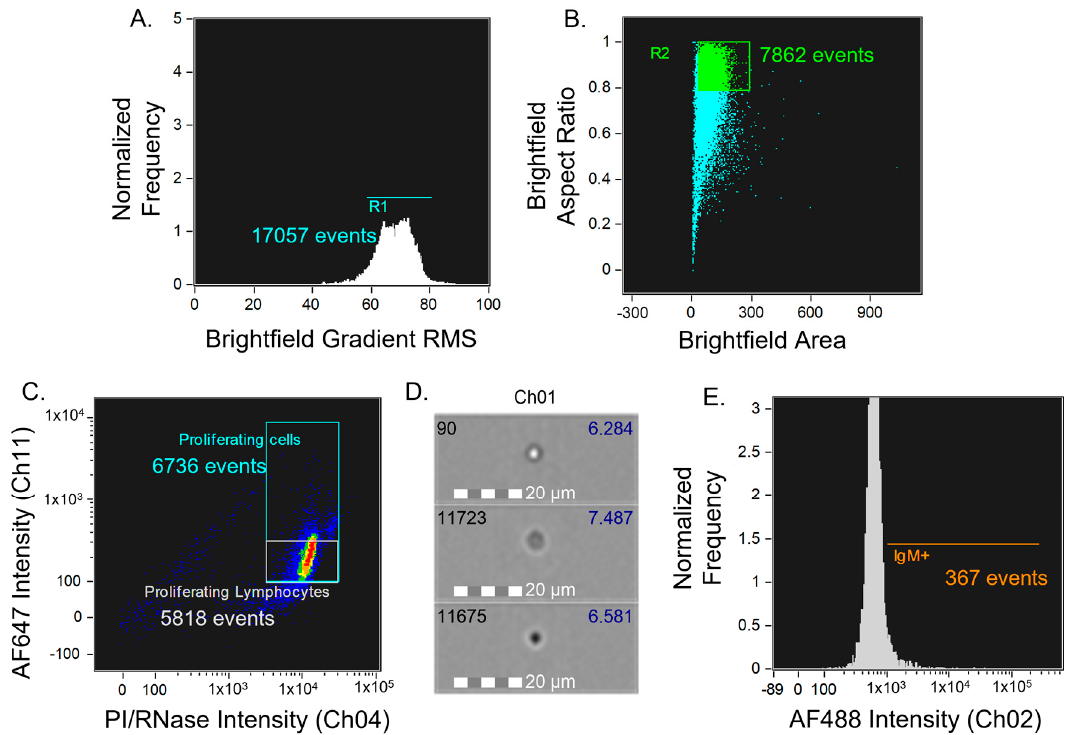
Figure 3. Gating strategy for creating batch file analysis template in the image software (IDEAS 6.3). A. Total events/cells (white) in focus were gated as R1 (cyan), B. Out of the R1 population (cyan), single round events/cells were gated as R2 (green), C. Out of the R2 population, proliferating cells (cyan) were gated based on concurrent fluorescent signals from PI/RNase (Ch04) indicating they were in the G2/M phase based on intensity of staining and AF647 (Ch11) indicating they were EdU+, D. Proliferating lymphocytes were selected (gray) for analysis based on features of brightfield images (round morphology, low side scatter, nucleus–cytoplasm ratio, nuclear shape) which were applied to the total population using the machine learning module and distinguished from total proliferating cells (cyan). Cell diameter ( µ m) is displayed in the top right corner of each image, E. AF488 (Ch02) positives show the number of IgM+ proliferating lymphocytes (orange) out of the proliferating lymphocyte population